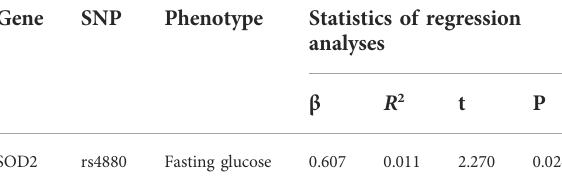
TABLE 5 Regression analysis on the impacts of rs4880 of SOD2 on fasting